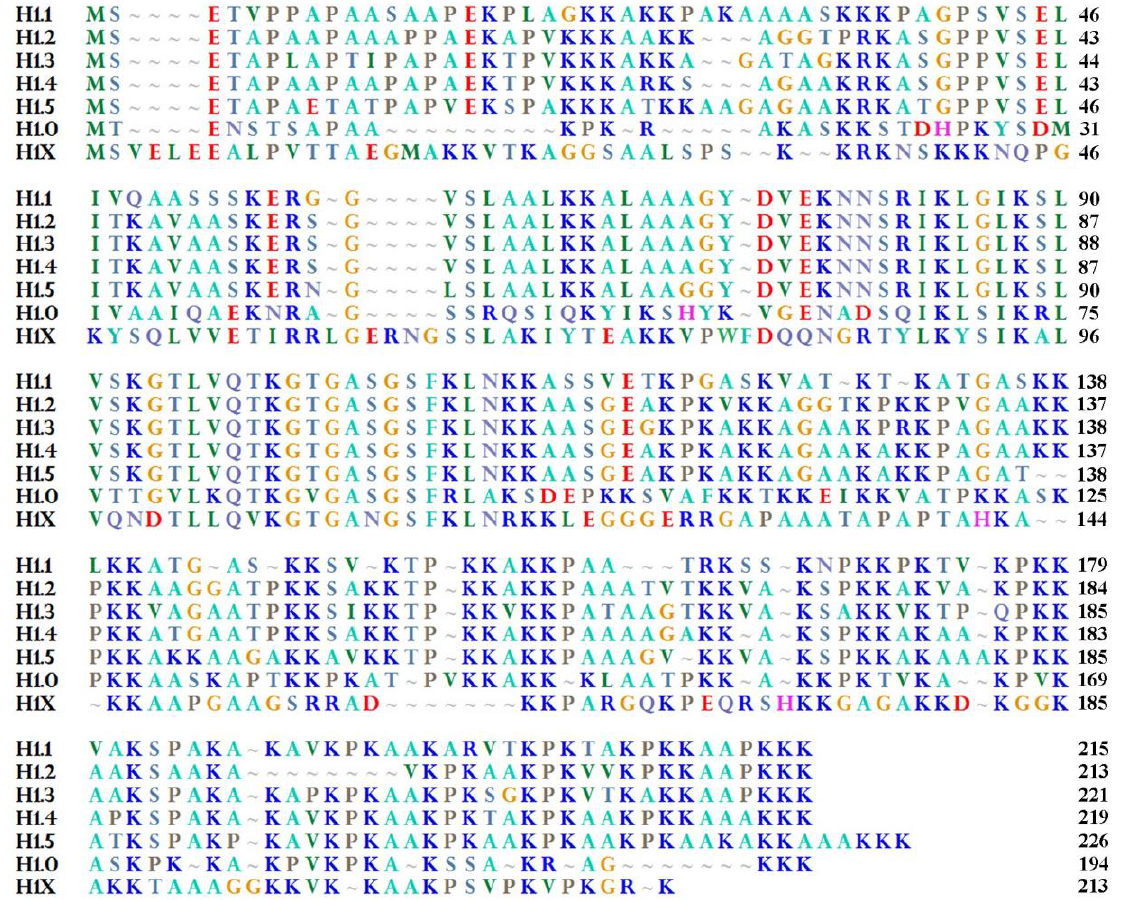
Figure 1. Alignment of all human somatic H1 linker histones. NCBI reference sequences reported: